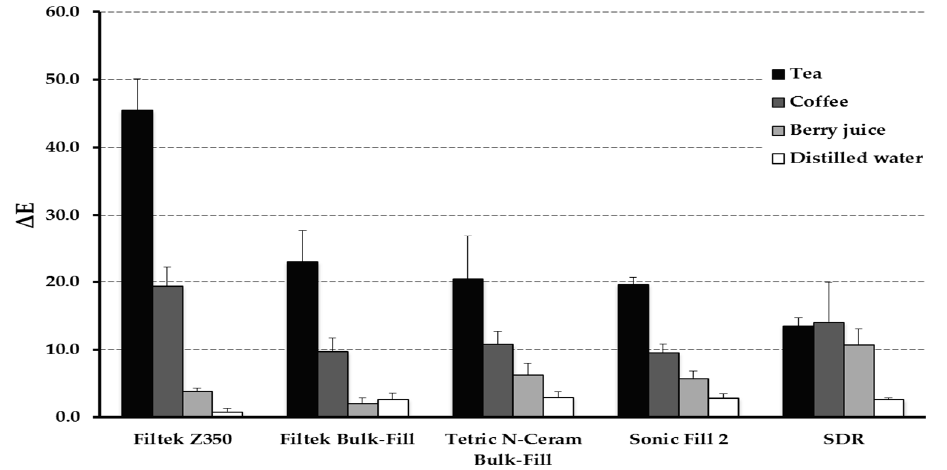
Figure 3. Bar graph showing Δ E values after 90 days of immersion in different solutions. Error bars represent standard error.